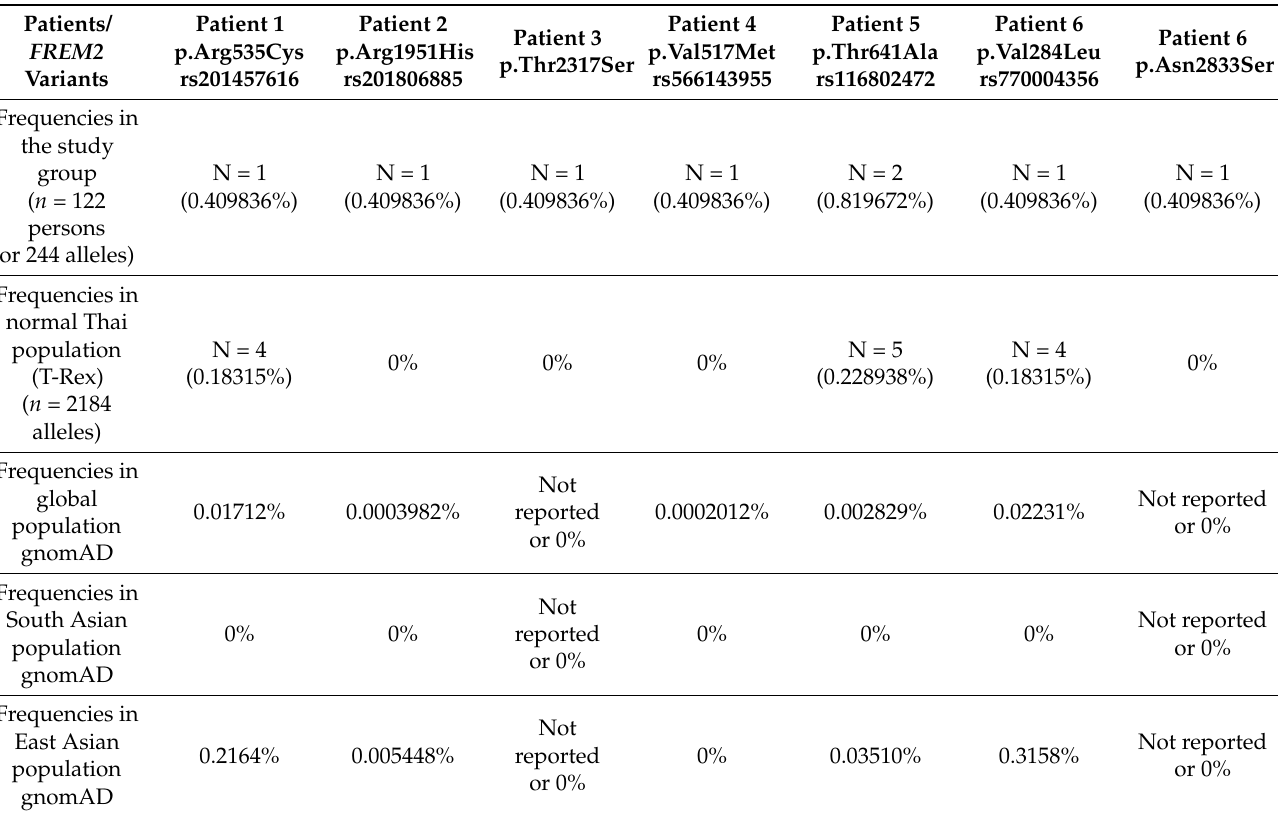
Table 2. Allele frequencies of the variants in different populations. Note the frequencies of the FREM2 variants are higher in the patient cohort than they are in various normal